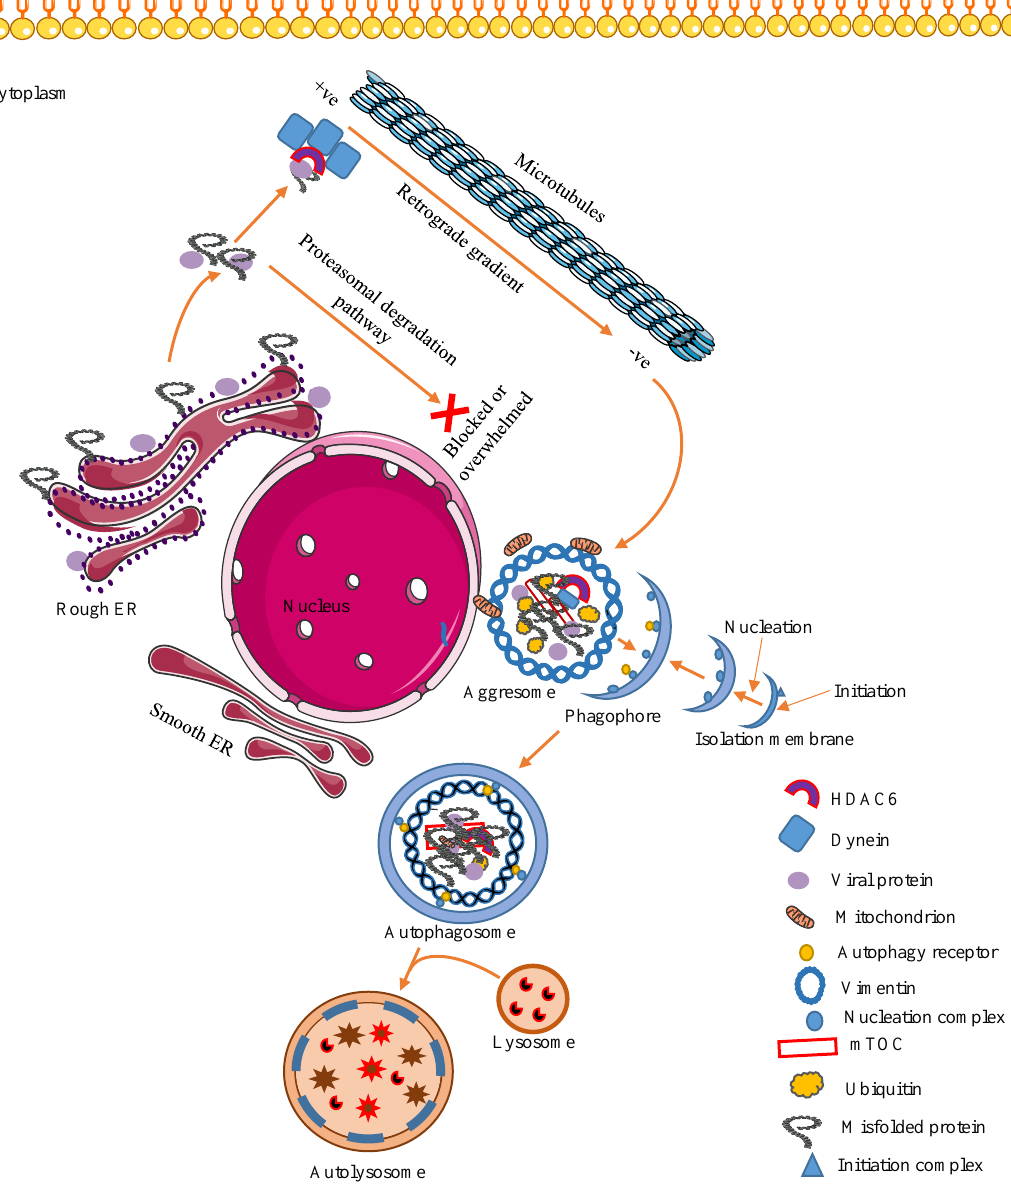
Figure 1. Virus-induced aggresome formation. The activation of the aggresome pathway is the result of an overwhelmed or blocked proteasomal degradation pathway. Aggresomes are formed around the MTOC at the perinuclear region of the cell by active minus-end-directed transport of proteins to the vimentin cage. HDAC6 is important for the aggregation of viral and or cellular misfolded / ubiquitinated proteins at the MTOC. These proteins are connected to dynein, a motor protein, and to HDAC6, a linker molecule with deacetylase activity. The aggresomes formed are cleared by an autophagosome–lysosome fusion event called aggrephagy. HDAC6, histone deacetylase 6, MTOC, microtubule organizing center, ER, endoplasmic reticulum. Figure adapted from [30]. Figure was drawn on